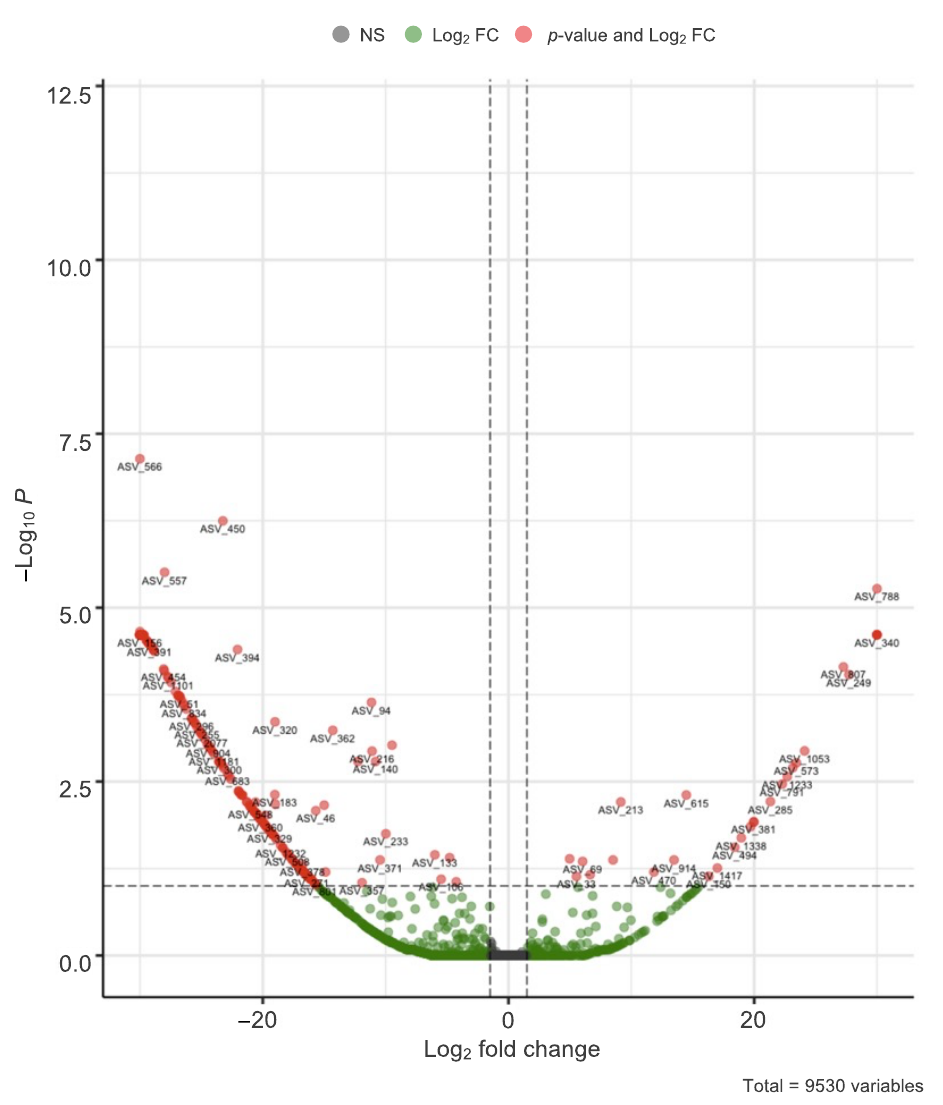
Figure 7. Volcano plot showing the differential abundance of ASVs due to the treatment effect. The statistical significance value was set to p -value < 0.01 (horizontal line), while, to be considered biologically significant, the effect size in terms of Fold Change (FC) should have had an absolute value higher than 3 (vertical lines at log 2 FC = 1.5).